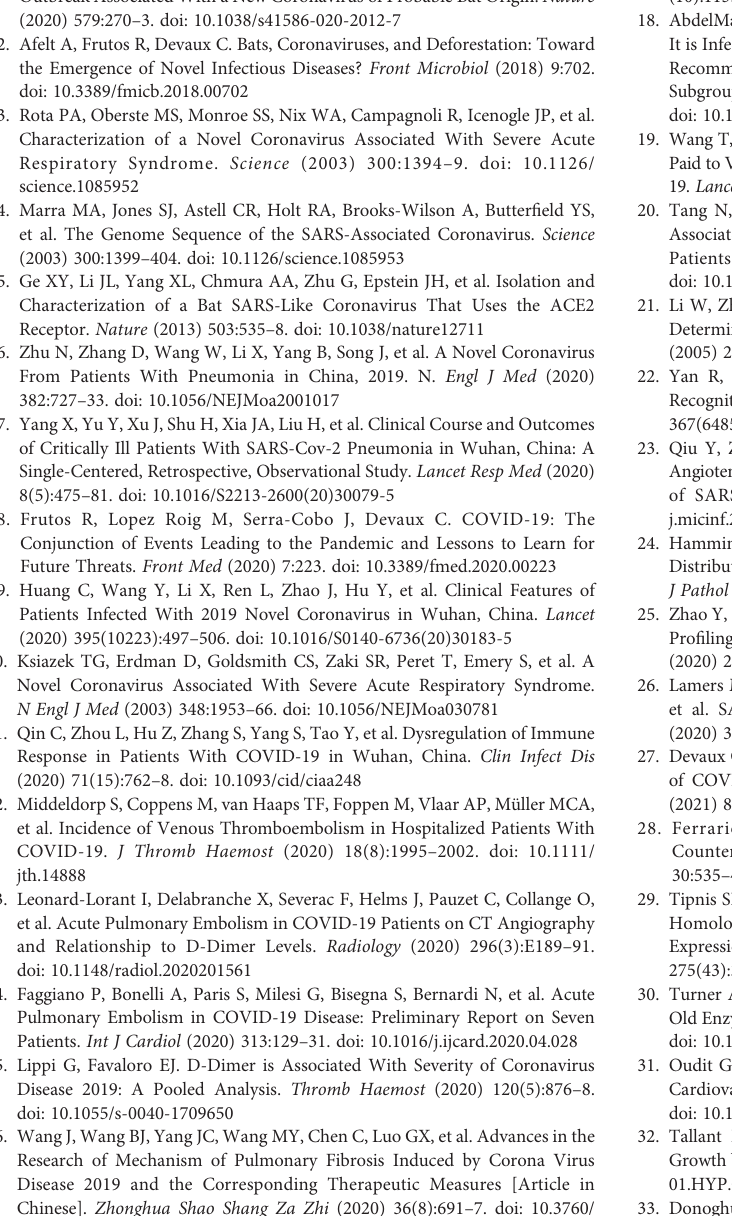
Supplementary Figure 1 | Histogram summarizing the data of fl ow cytometry analysis of ACE2 expression at the surface of T-cells, B-cells and monocytes. Comparison of percent cells expressing ACE2 and ACE2 MFI on cell samples from prolonged viral shedders (n=12), patients short viral shedders (n=12) and healthy volunteers (n=12). The gating was performed using different cluster differentiation- speci fi c mAb allowing to select subpopulation of lymphocytes CD3 + T-cells, CD20 + B-cells and HLA-DR + /CD16 + monocytic/dendritic cells. The left panels indicate the percent of cells expressing ACE2 with respect to the cells subpopulation analyzed while the right panels are the histograms of ACE2 cell surface expression (MFI).